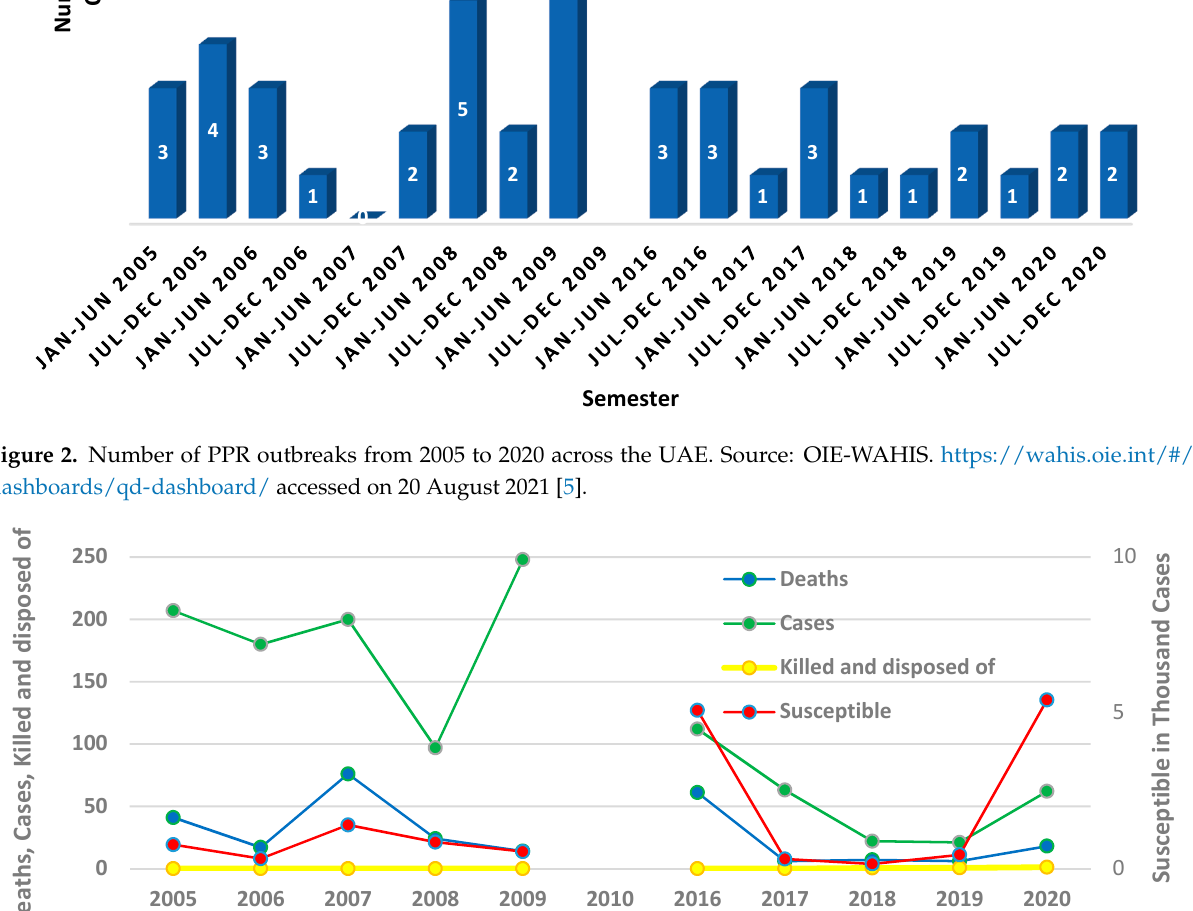
Figure 3. Quantitative data on PPR outbreaks from 2005 to 2020 across the United Arab Emirates (UAE). Source: OIE-WAHIS.